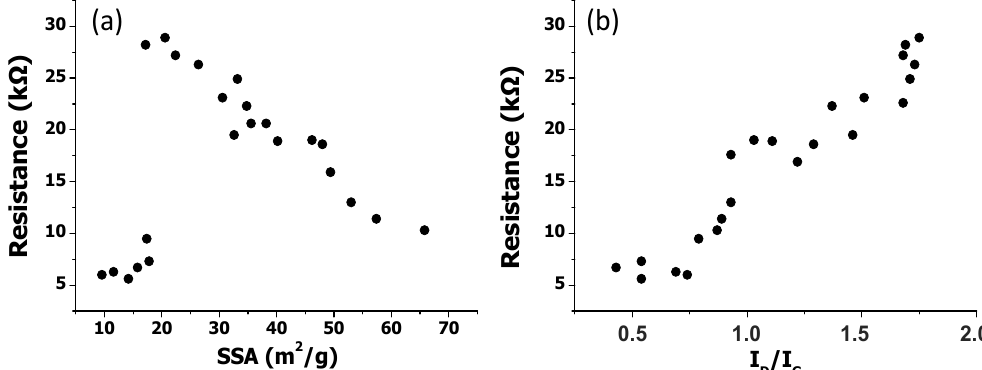
Figure 5. Electrical resistance vs. specific surface area SSA ( a ), and vs. I D / I G band intensity ratio obtained from the Raman spectra ( b ).